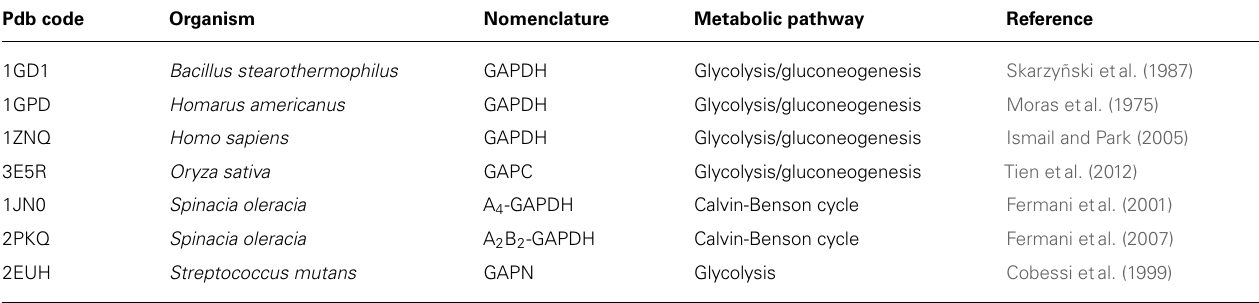
Table 1 | List of selected GAPDH isoforms from diverse organisms for which the three-dimensional structure has been solved. Pdb